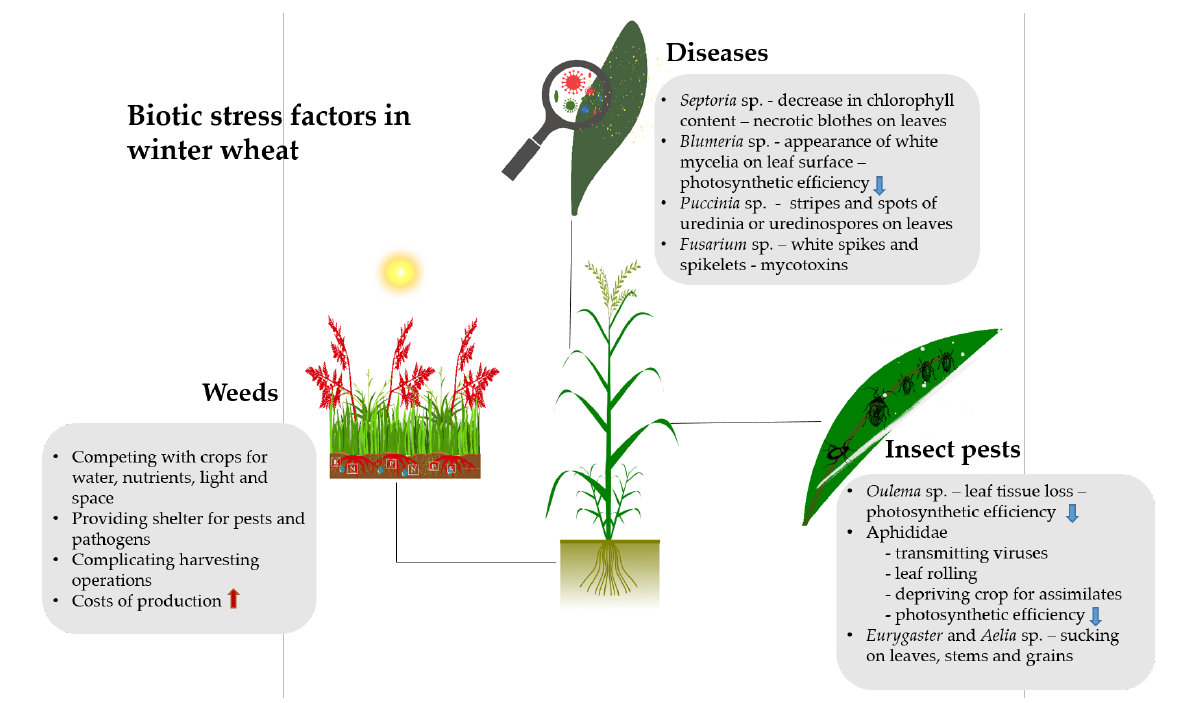
Figure 2. Biotic stress factors (diseases, weeds and insect pests) in winter wheat and their corre- sponding physiological responses of winter wheat ( ↑ symbol represents increase and ↓ symbol represents decrease )